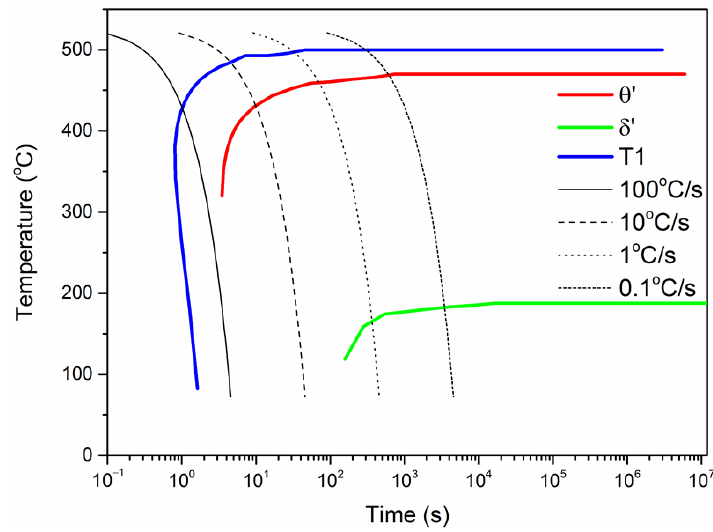
Figure 14. The CCT diagram of 2A97 alloy.